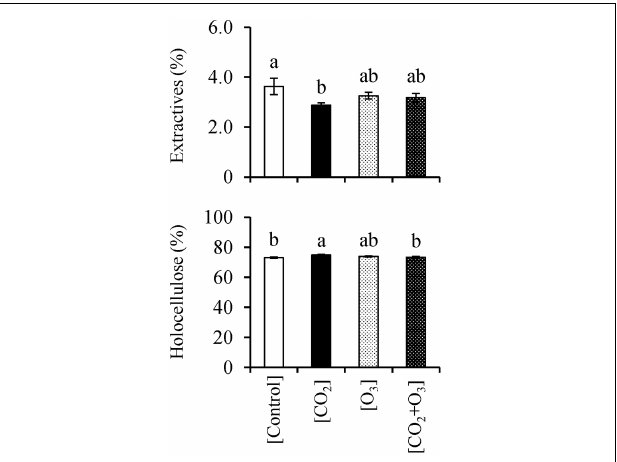
FIGURE 4 | Ethanol/benzene extractives and holocellulose contents in Q. mongolica seedlings subjected to conditions of atmospheric CO 2 and O 3 concentration ([Control]), elevated CO 2 concentration ([CO 2 ]), elevated O 3 concentration ([O 3 ]), and a combination of elevated CO 2 and O 3 concentrations ([CO 2 + O 3 ]). Bars indicate standard errors. Different letters indicate significant differences among treatments (Tukey method: p <